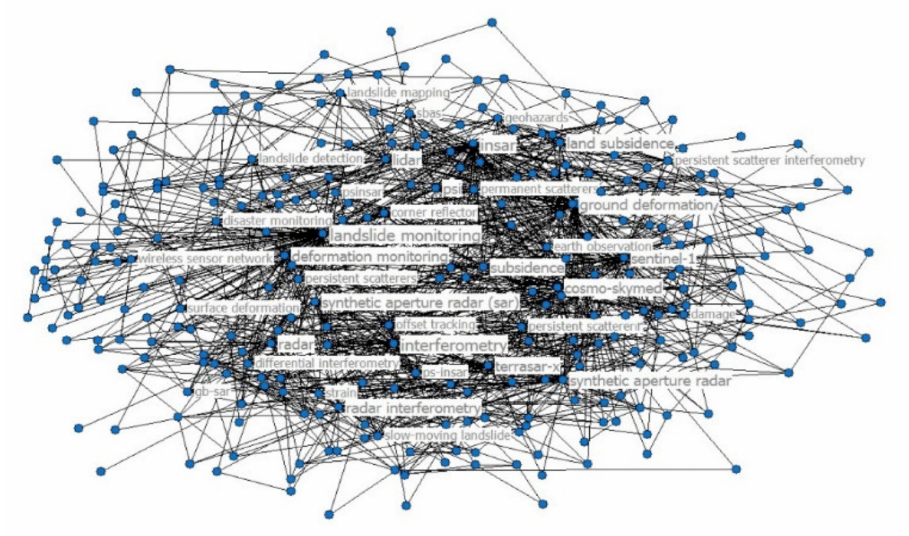
Figure 7. Betweenness evolution of subject keywords.